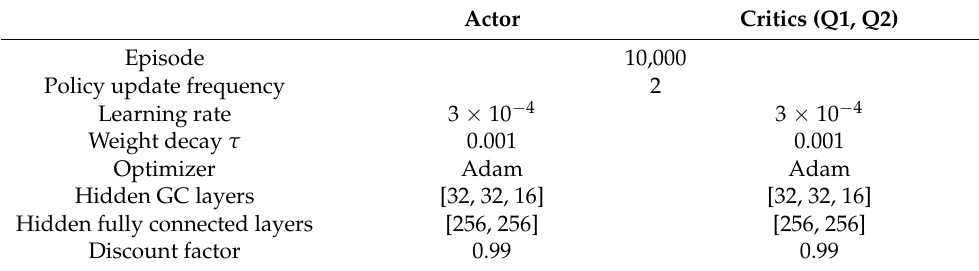
Table 4. Hyperparameters values of Actor and Critic networks used for the training process.